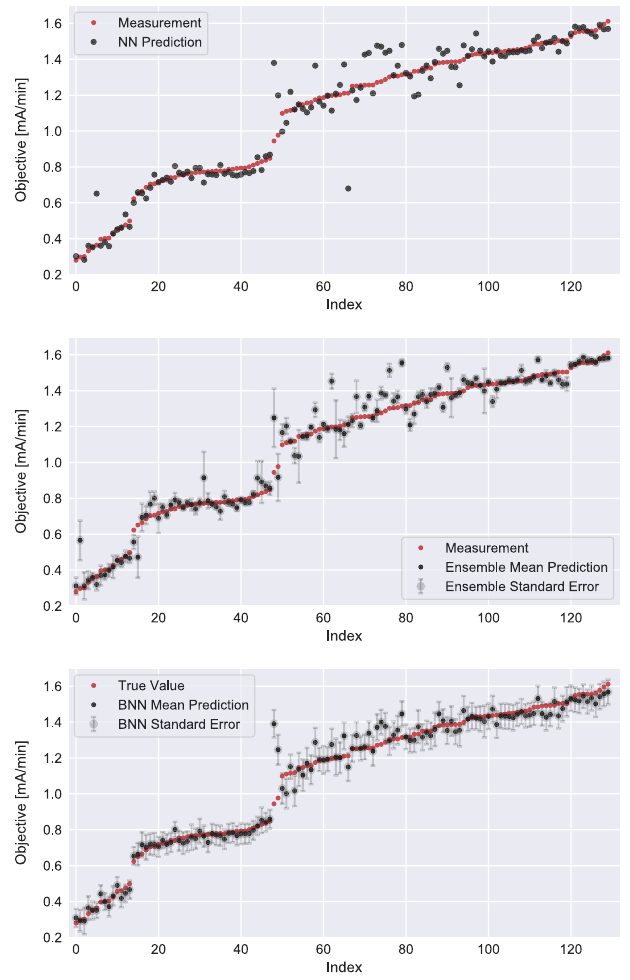
FIG. 2. Deterministic neural network, ensemble and Bayesian neural network model mean predictions and predicted standard error for SPEAR3 measured data.